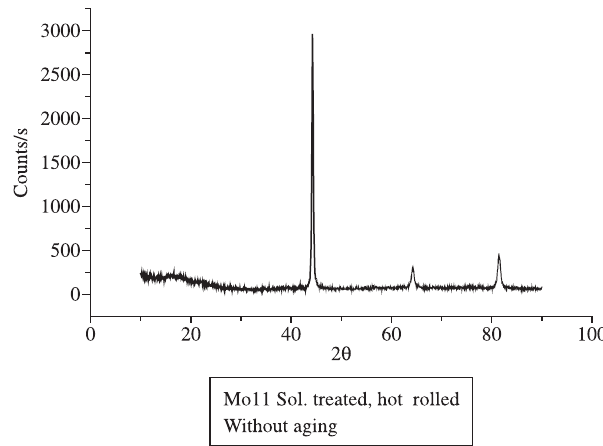
Figure 4. Diffractogram of alloy containing 11 wt. (%) Mo, solution treated at 1250 °C, after hot rolling, without aging.